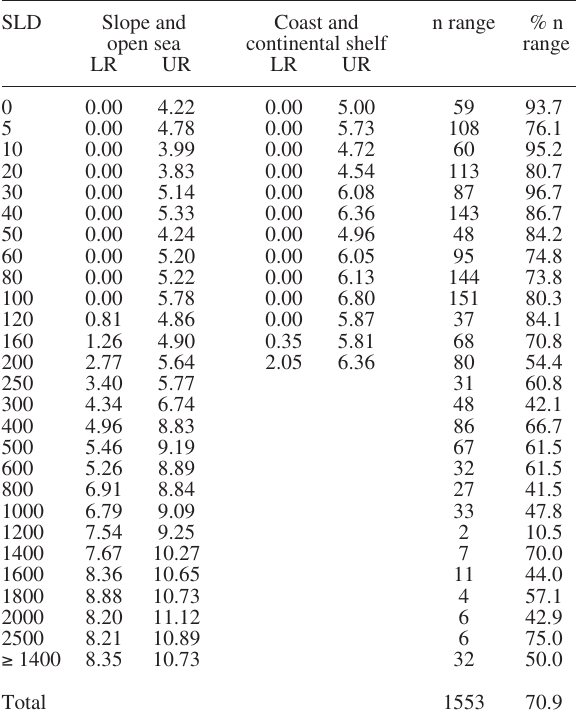
Table 15. – Silicate concentration ( m M) ranges in the NW Mediter- ranean Sea in mixed water columns (stratification coefficient = 1). Headers as in Table 7.